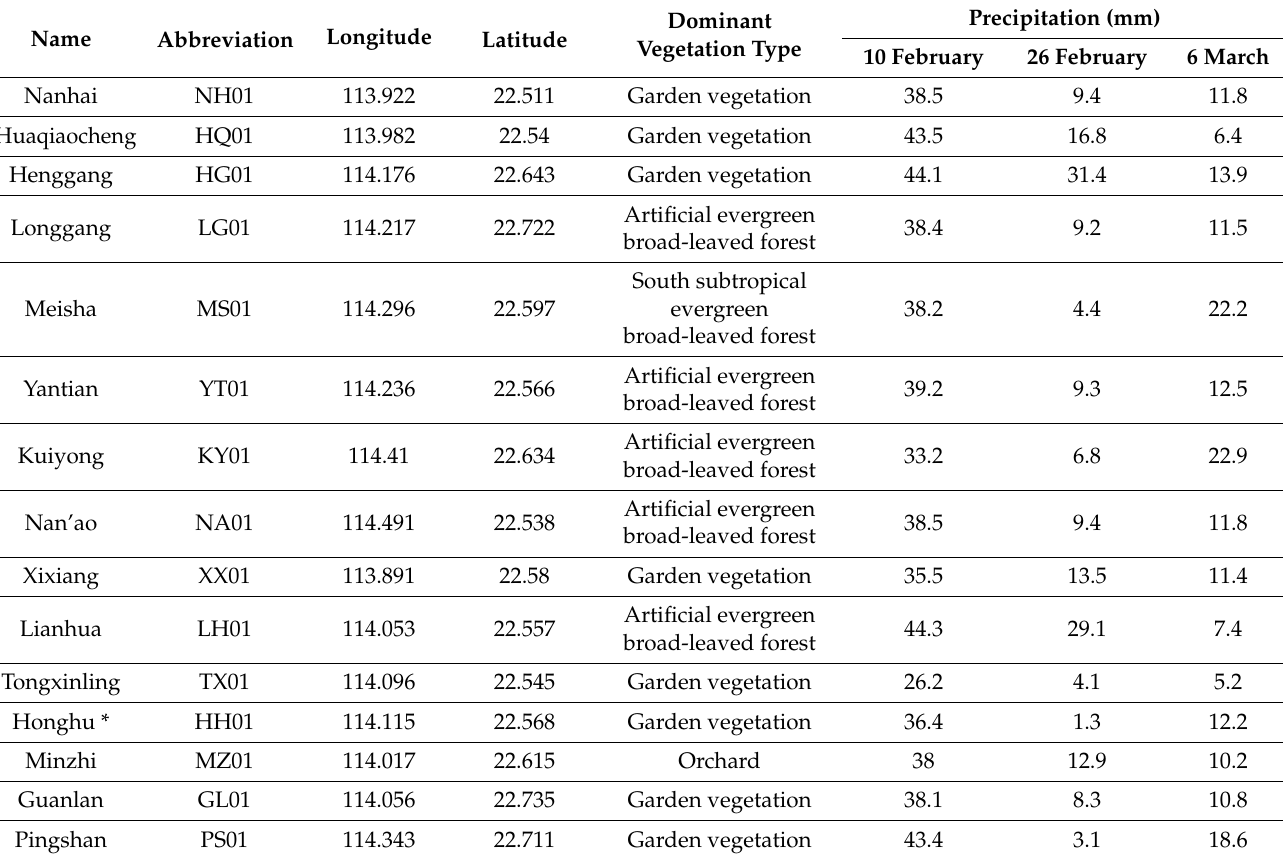
Table 1. Rainfall over 3 periods for 15 stations, interpolated by